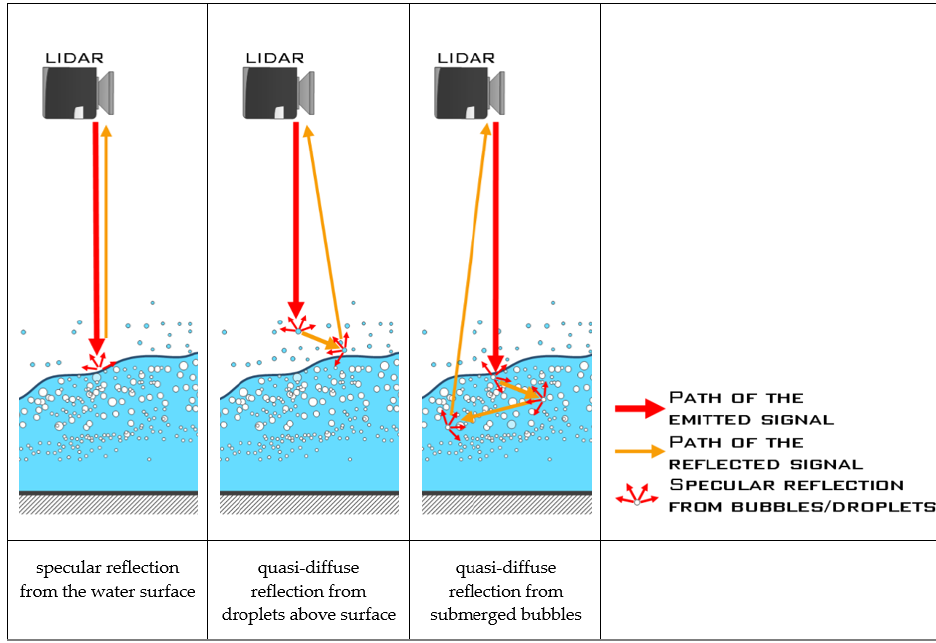
Figure 3. Different types of laser beam reflections during LIDAR measurements.